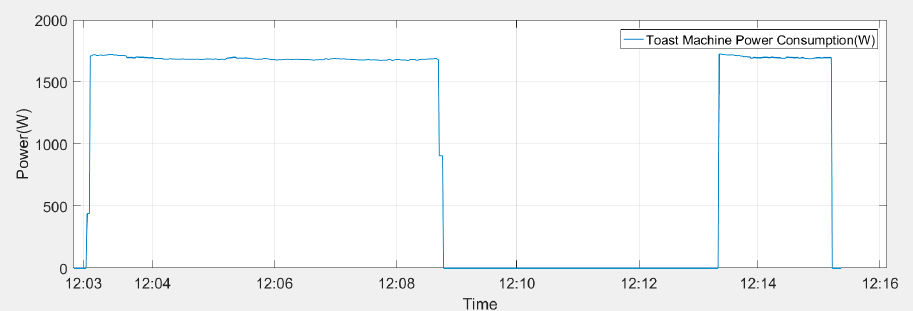
Figure 16. The power consumption curve of the toast machine for the obtained sample case.